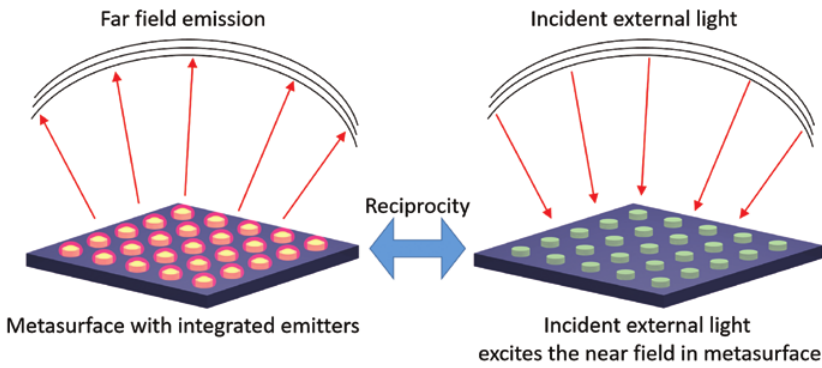
Figure 9: The concept of the calculations based on the reciprocity principle. The far-field emission from the metasurface with integrated incoherent emitters is reciprocal to the intensity of the near-field excited in the metasurface by the incident external light averaged over the positions of the